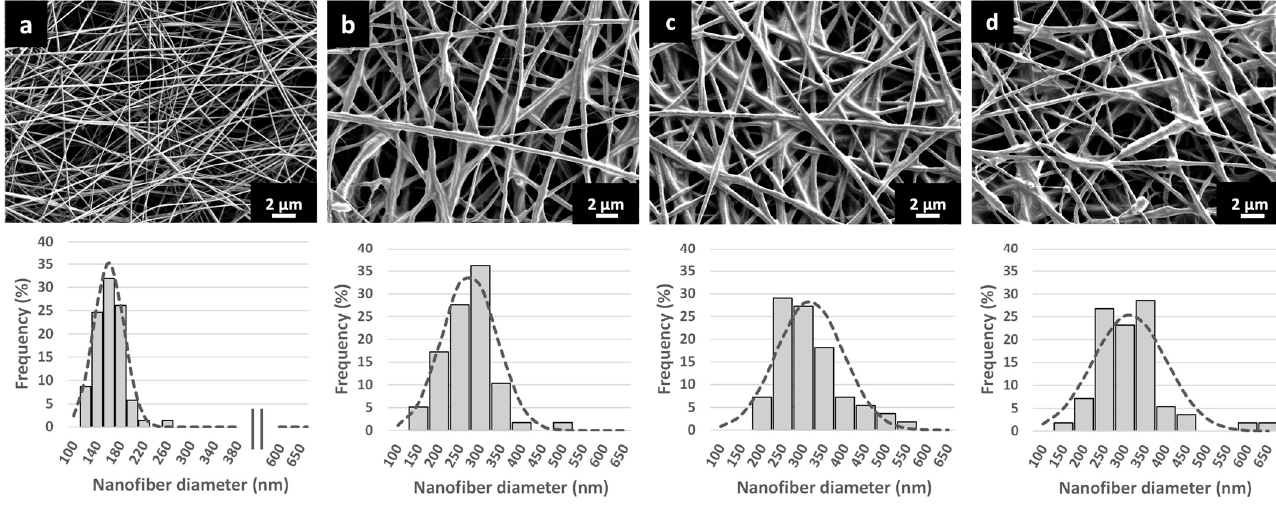
Figure 2. SEM images (upper panel) and diameter distribution (lower panel) of ( a ) EMPTY-NF, ( b ) SIM LIPO-NF, ( c ) 0.6-BHA SIM LIPO-NF, and ( d ) 1.2-BHA SIM LIPO-NF.